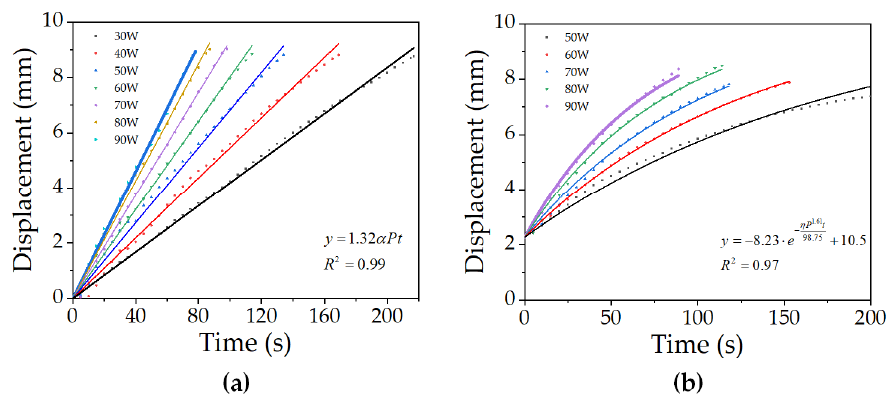
Figure 10. Data postprocessing: curve fitting in the ascending phase ( a ) in air and ( b ) underwater.